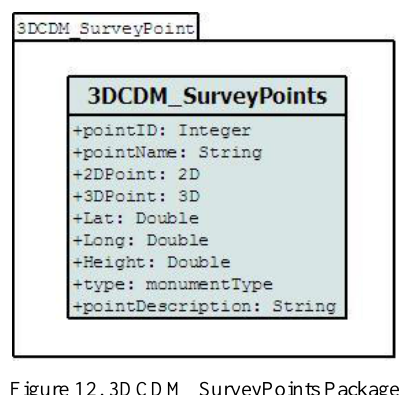
Figure 12. 3DCDM_SurveyPoints Package